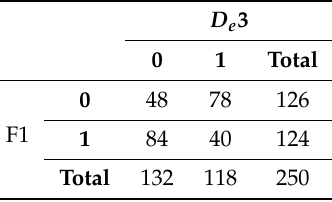
Table 7. Cross tabulation of variables F1 and D e 3, for respondents with K1 = 1.